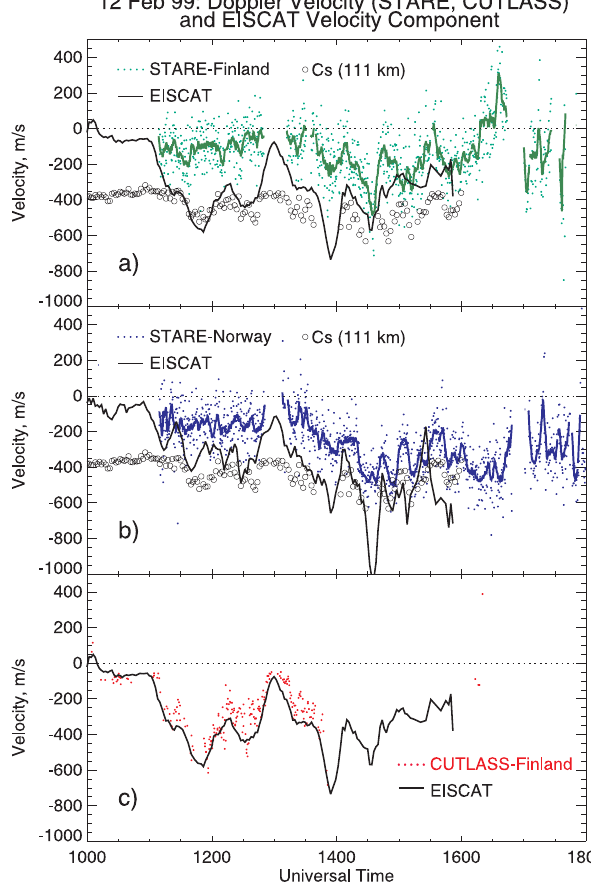
Fig. 5. (a) Finland STARE (green dots) beam 3 Doppler veloc- ity in bin 27 versus time and the EISCAT convection component (solid line) along beam 3. The solid green line represents smoothed behaviour of the STARE velocity. (b) Norway STARE (blue dots) beam 4 Doppler velocity in bin 17 and the EISCAT convection com- ponent (solid line) along beam 4 versus time. The blue solid line represents smoothed behaviour of the STARE velocity. (c) Han- kasalmi CUTLASS beam 5 Doppler velocity (red dots) in bin 16 and the EISCAT convection component (solid line) along this beam versus